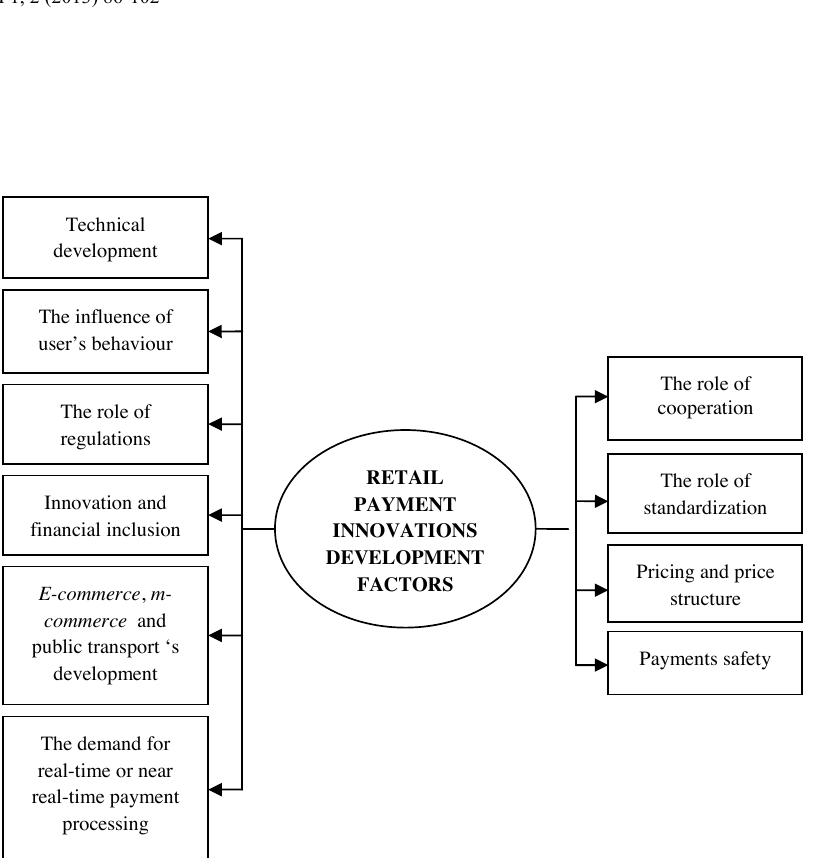
Fig. 1 The factors influencing retail payment innovations development (Harasim, 2013) Exogenous factors relate to those that are determined outside the payments ecosystem, notably technical developments, user behaviour and regulations. On the other side, endogenous factors are determined inside the payments ecosystem,